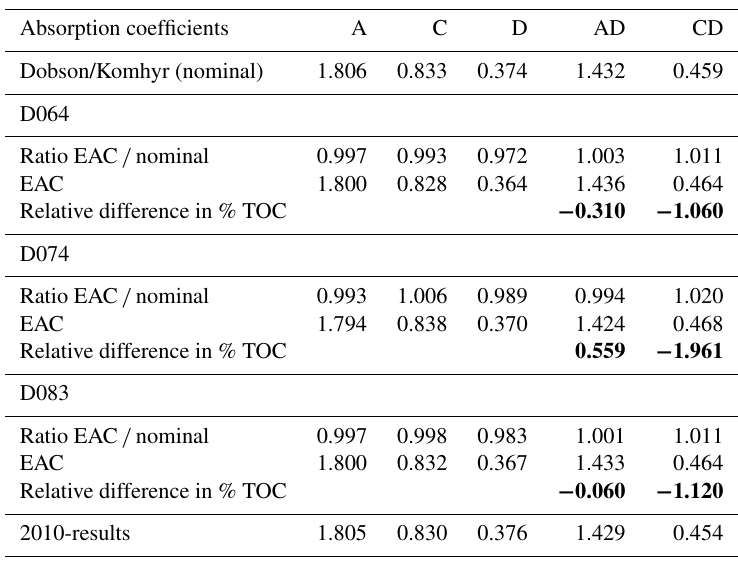
Table 3. Effective Absorption Coefficients (EACs) calculated with Bass–Paur cross sections, their ratio to the nominal ones and the resulting relative difference in % TOC. 2010-results from measurements of the D083 spectral characteristics (Evans et al., 2012) are shown as well. Relative TOC-differences in the most relevant observation modes AD and CD are marked in